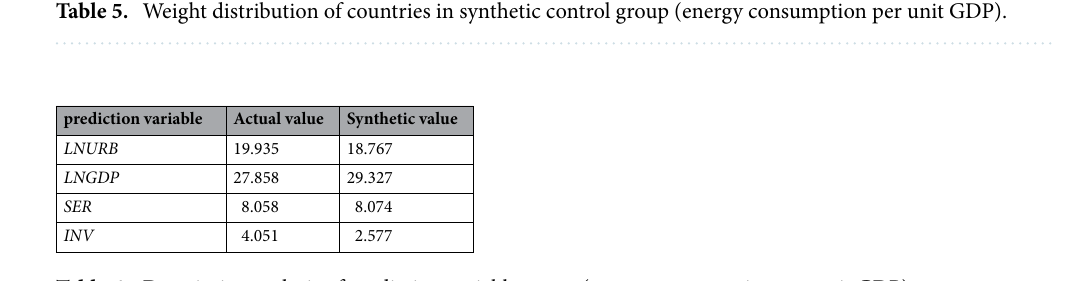
Table 6. Descriptive analysis of prediction variable group (energy consumption per unit